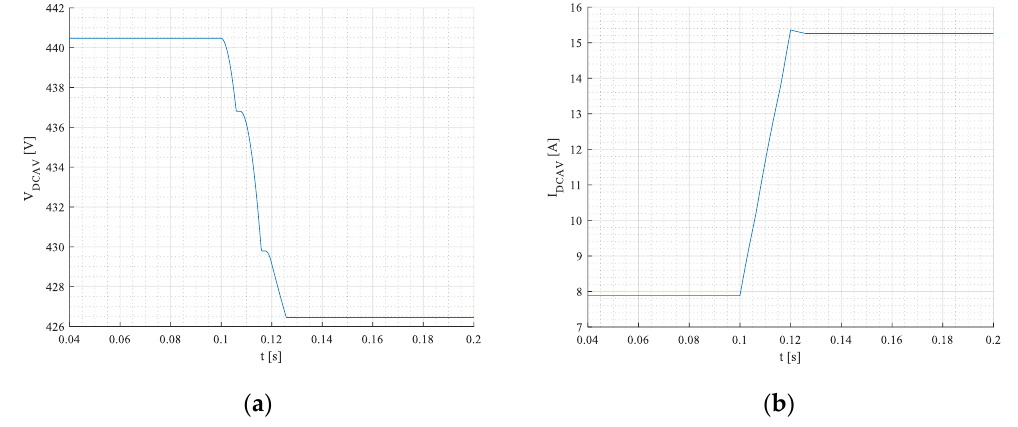
Figure 19. Voltage ( a ) and current ( b ) on the DC side under resistive load.